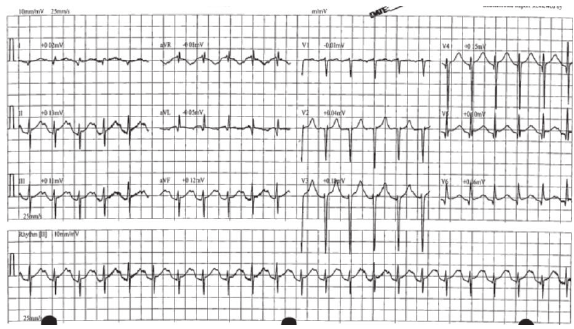
Figure 2: Presenting ECG showing sinus tachycardia at 136 beats/min, ST-elevations in leads V3-V6, II, III, and aVF. angiogram showed moderate-severe bronchiectasis, dextro- cardia, scarring of the right lung base, and mediastinal